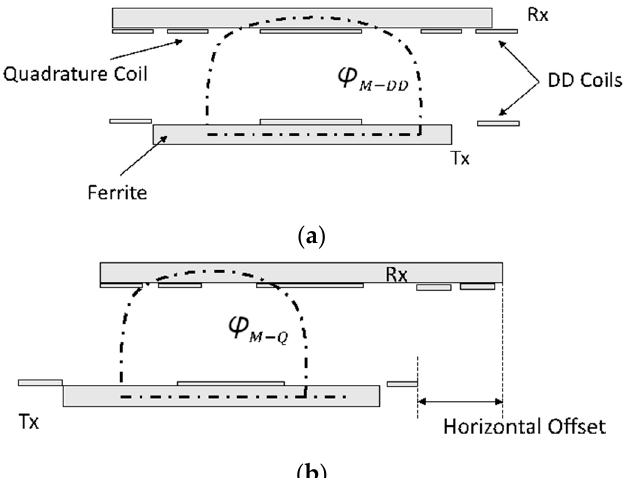
Figure 6. DDQ pad receiver coupled with a DD pad transmitter in different positions ( a ) centrally aligned and ( b ) null point [21].